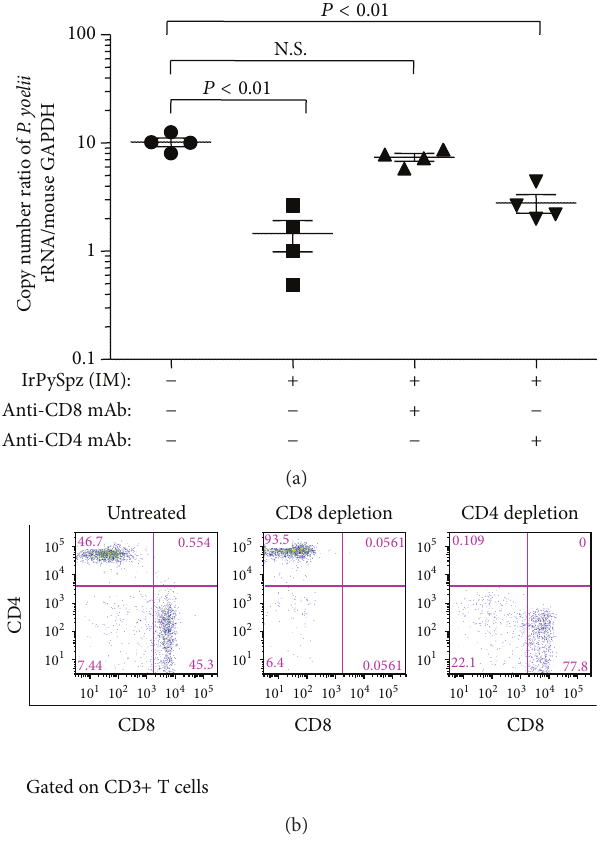
Figure 3: Protection against plasmodium infection in IrPySpz- immunized MHC-I- 𝐾 𝑑 -Tg mice after depletion of CD8+ T cells or CD4+ T cells. (a) Groups of MHC-I-K d -Tg mice (4 per group) were immunized with 1 × 10 5 IrPySpz via IM injection following challenge with 5 × 10 4 viable P. yoelii sporozoites via IV injection at 2 weeks after immunization. Some cohorts of mice were treated with rat anti-CD4 mAb (GK1.5) or anti-CD8 mAb (YTS 169) 3 days and 1 day prior to challenge with P. yoelii sporozoites. Naive MHC-I-K d -Tg mice were challenged as infection control. The value of parasite burden was described previously. (b) The dot plots by flow cytometric analysis represent the frequency of total CD4+ and CD8+ T cells among the CD3+ T-cell population of splenocytes, following the indicated antibody treatment to IrPySpz-immunized MHC-I-K d -Tg mice.